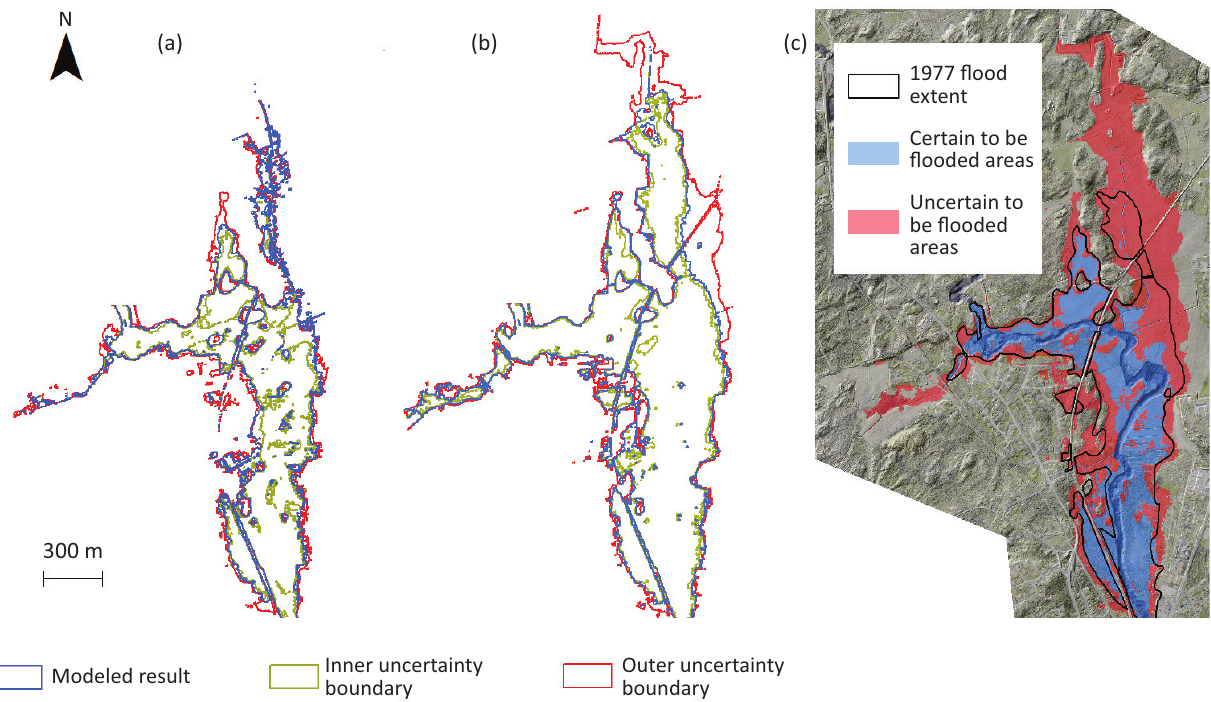
Figure 5. Example of model results for the Testebo river produced by the new GIS‐tool. (a) Uncertainty zones from low‐roughness 1D model; (b) uncertainty zones from high‐roughness 1D model; and (c) resulting increased uncertainty zone serving as a resilience